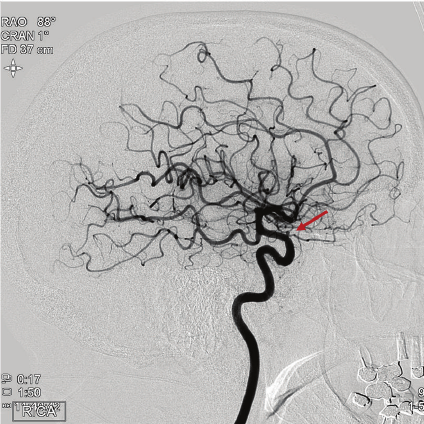
Figure 1: Cerebral angiogram showing 1.8 × 1.6mm right oph- thalmic artery aneurysm.